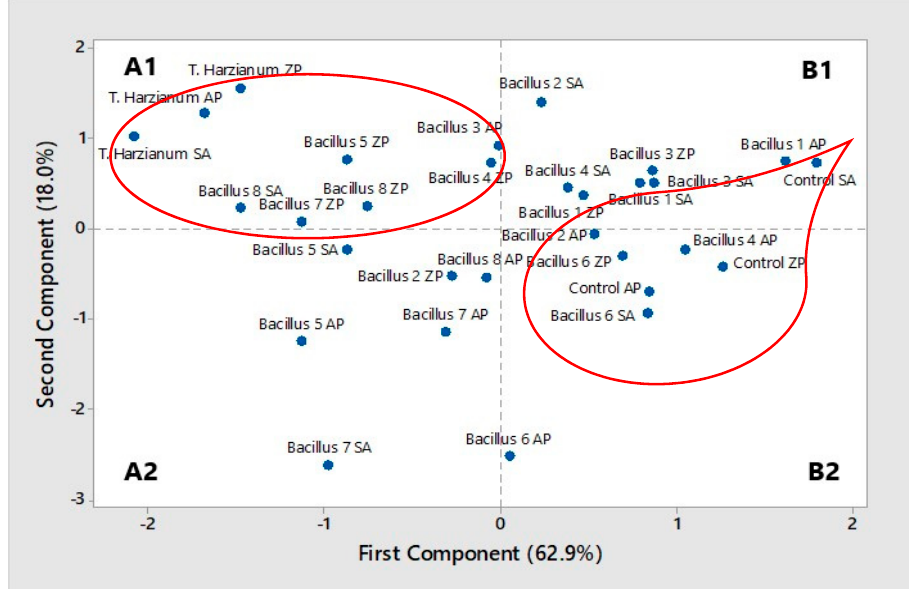
Figure 4. Principal component analysis (PCA) for the treatment effect on germination presence of fungi ( Fusarium sp., Alternaria sp., Penicillium sp., Mucor sp.) and the shoot and root length, AP